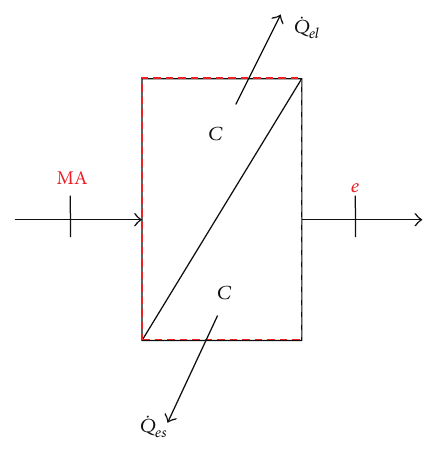
Figure 4: Schematic controlled volume of cooling coil